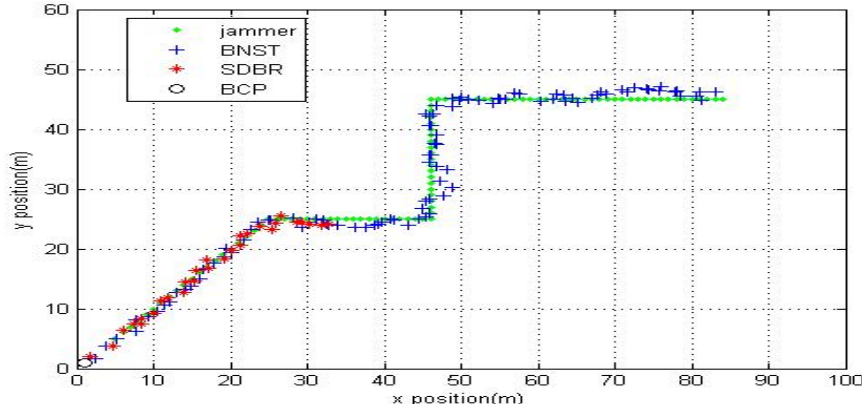
Figure 10. The percentage error of the selected boundary nodes when the jammer’s transmission range was adjusted to 15 m, 20 m, 30 m, and 35 m.